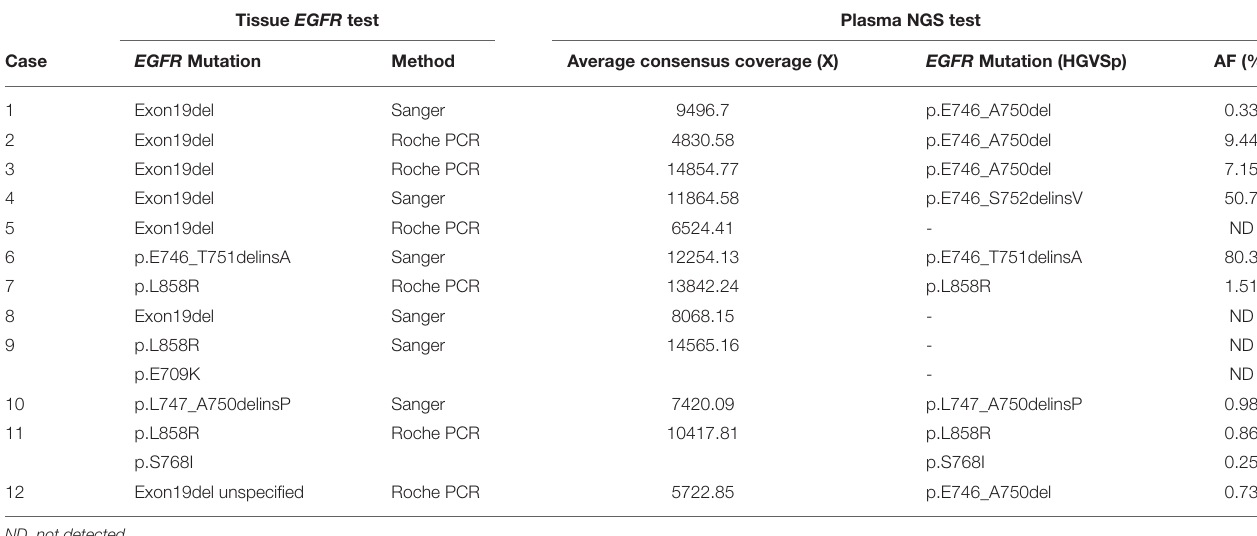
TABLE 3 | Depth of coverage by plasma NGS and detection of EGFR mutation and mutation allele frequency (AF %).